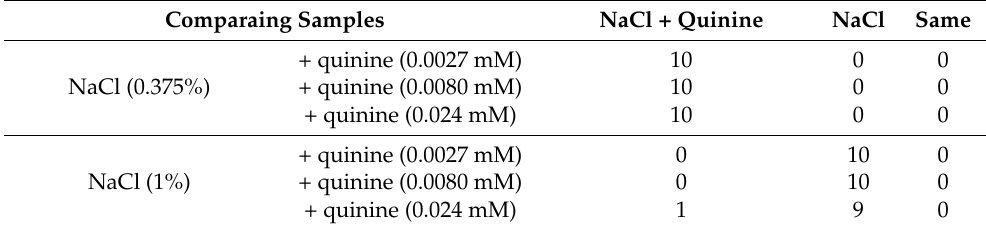
Table 3. Results of sensory test on quinine. The data is the number of panelists who decided which of the two samples was saltier. The comparing samples are NaCl solutions and the same NaCl solutions with quinine added.